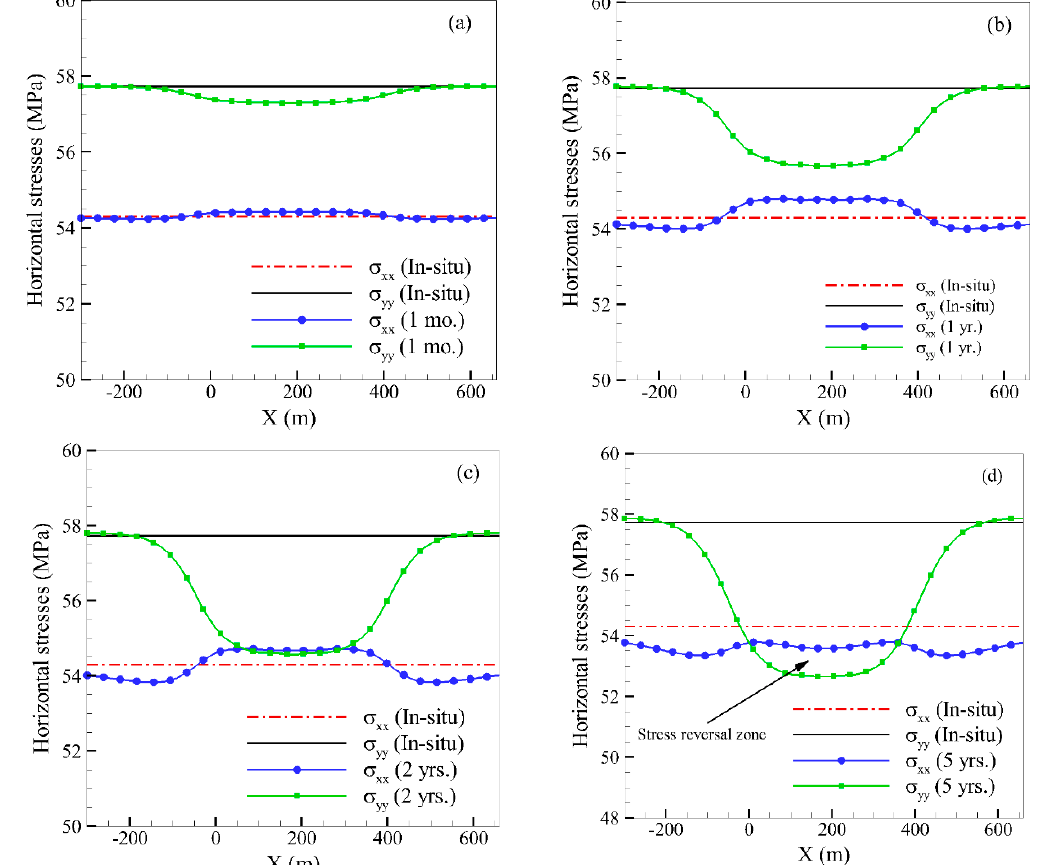
Figure 18. Variation of horizontal stress components σ xx , and σ yy along the infill well axis in the central XY-plane after ( a ) 1 month ( b ) 1 year ( c ) 2 years and ( d ) 5 years of production. It can be noticed after 2 years of production time, the horizontal stresses 𝜎 (cid:3051)(cid:3051) and 𝜎 (cid:3052)(cid:3052) have approximately similar magnitudes near the infill well location, which suggests that after 2 years of production time, stress reversal will occur in this zone.